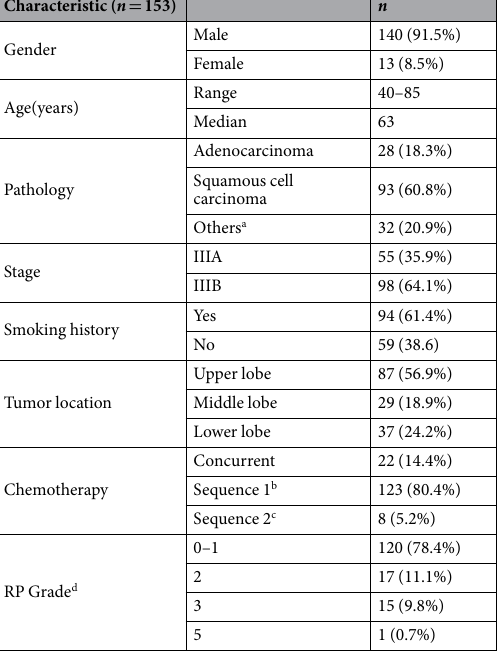
Table 1. Demographics of patients. a Other types of pathology included adenosquamous carcinoma and some NSCLC with a non-clear diagnosis. b Sequence 1, patients who received chemotherapy first. c Sequence 2, patients who received radiation therapy first. d RP, radiation